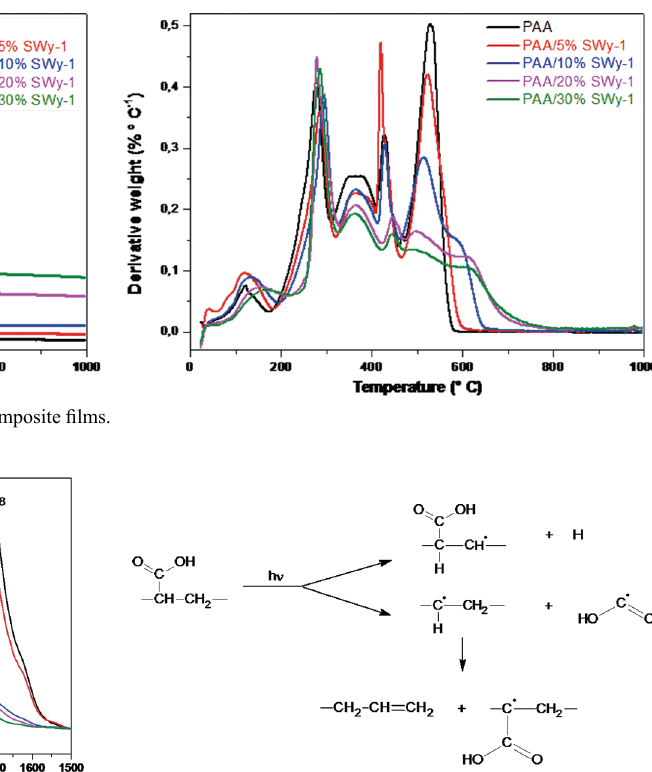
Figure 7. Schematic showing the photodegradation of pure PAA